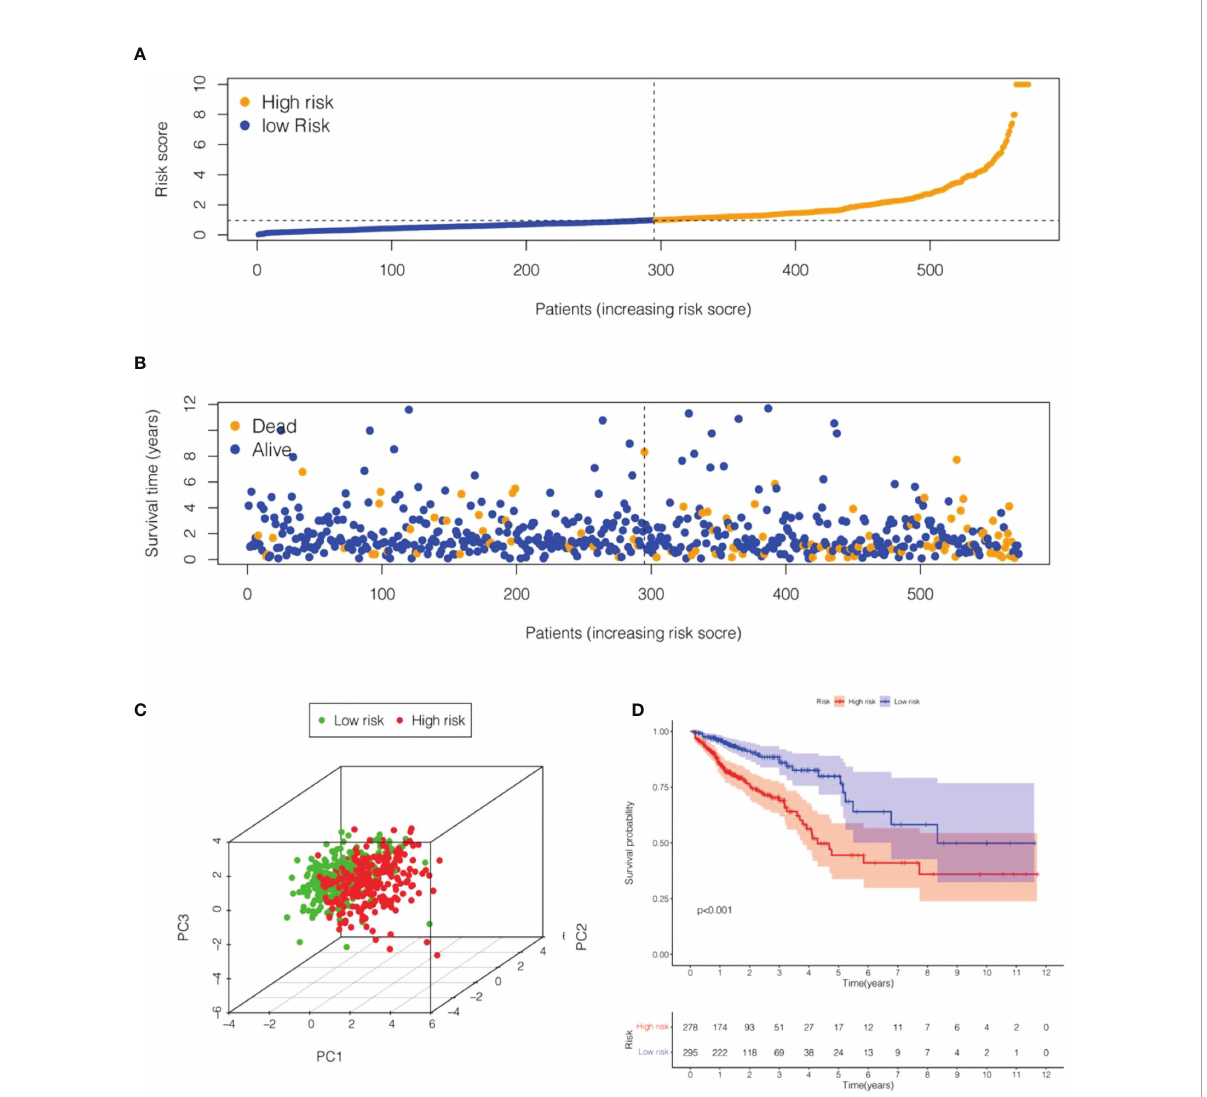
FIGURE 7 Risk model for 6 cell senescence-related lncRNAs with prognostic value in TCGA-COADREAD. (A) Distribution of risk scores and different groupings in TCGA-COADREAD. (B) Relationship between risk score and survival status in TCGA-COADREAD. (C) . 3D PCA for high and low risk groups in TCGA-COADREAD. (D) Kaplan-Meier analysis of the OS for high and low risk groups in TCGA-